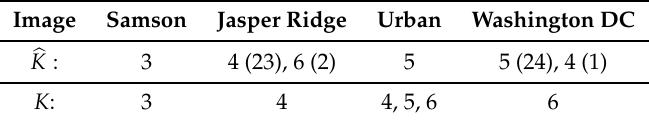
Table 2. Estimated number of endmembers ( (cid:98) K ) obtained in each image after executing our algorithm 25 times. The groundtruth value of K is also provided for comparison.